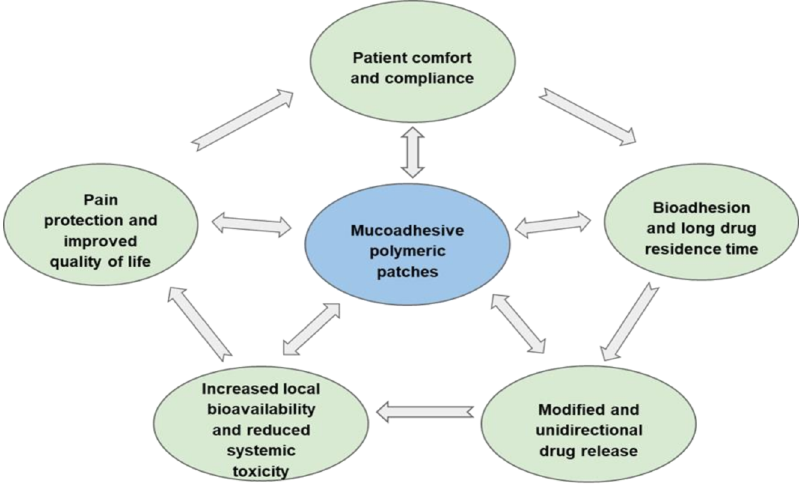
Figure 1. The main biopharmaceutical advantages of patches as optimal dosage forms for oromucosal delivery of topical corticosteroids.